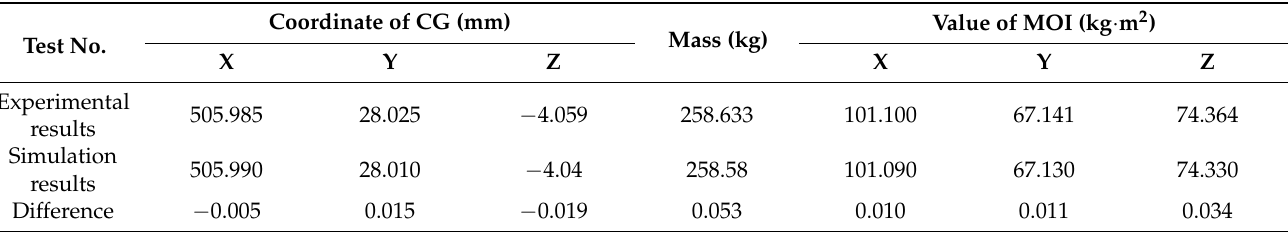
Table 4. Comparison between measurement results and simulation